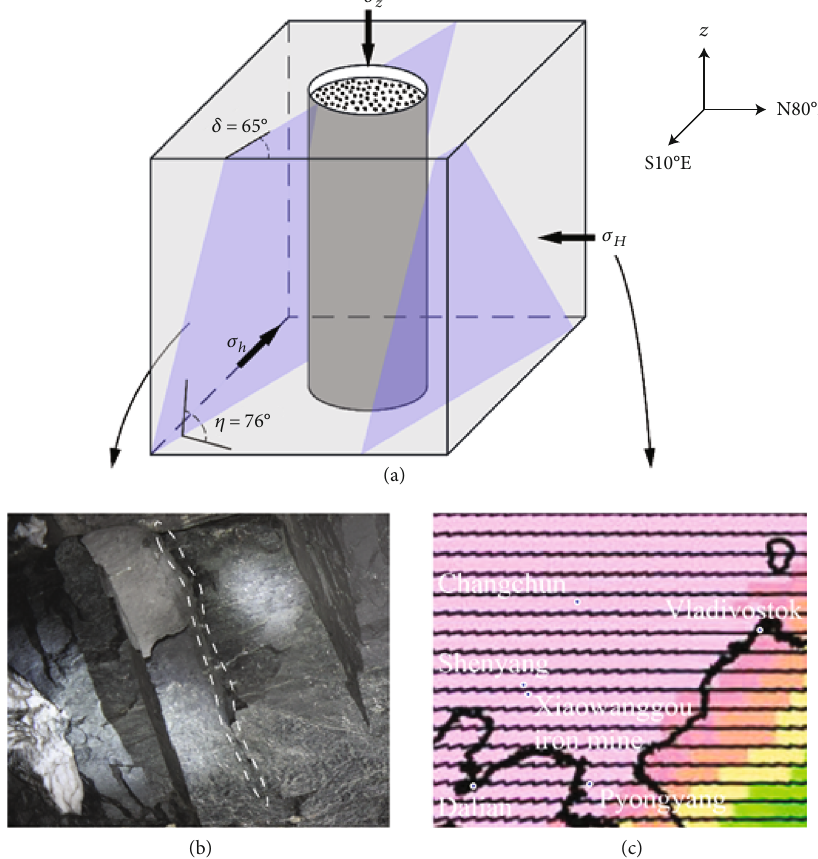
Figure 5: (a) The distribution of caved space, in situ stress, and discontinuities in 3D space. (b) In situ observation for the discontinuities in the undercut in Xiaowanggou iron mine. (c) The orientation of mean maximum horizontal in situ stress (represented by black bar) around Xiaowanggou iron mine. Table 1: Parameters of the surrounding intact rocks, caved rocks, and discontinuities. Surrounding intact